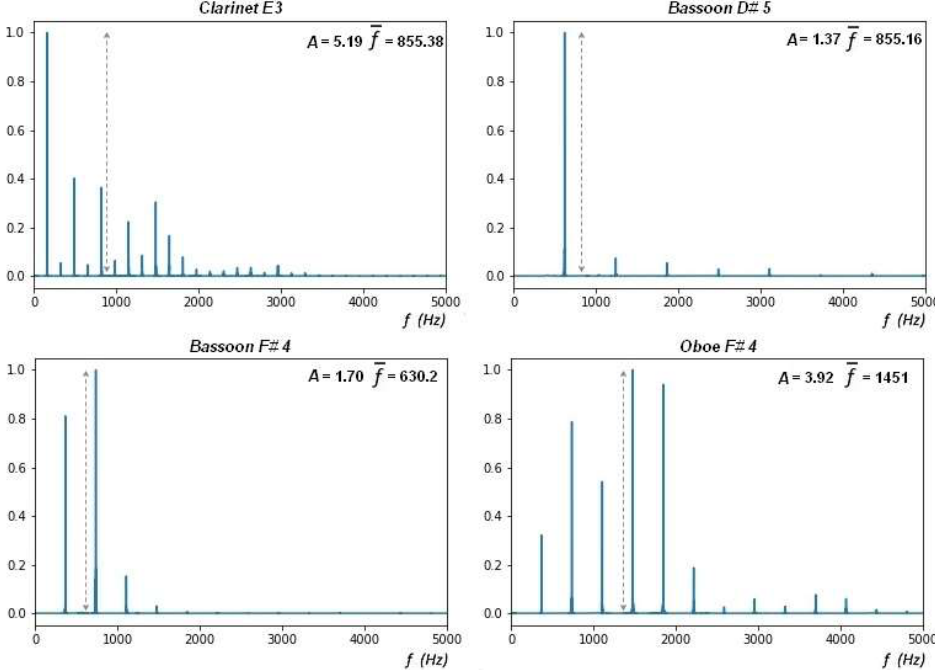
Figure 3. Examples of Fourier spectra for sounds with different Affinity coefficients and similar centroids (top panel) and the same sound in different aerophones. The dashed line indicates the relative location of the centroid.